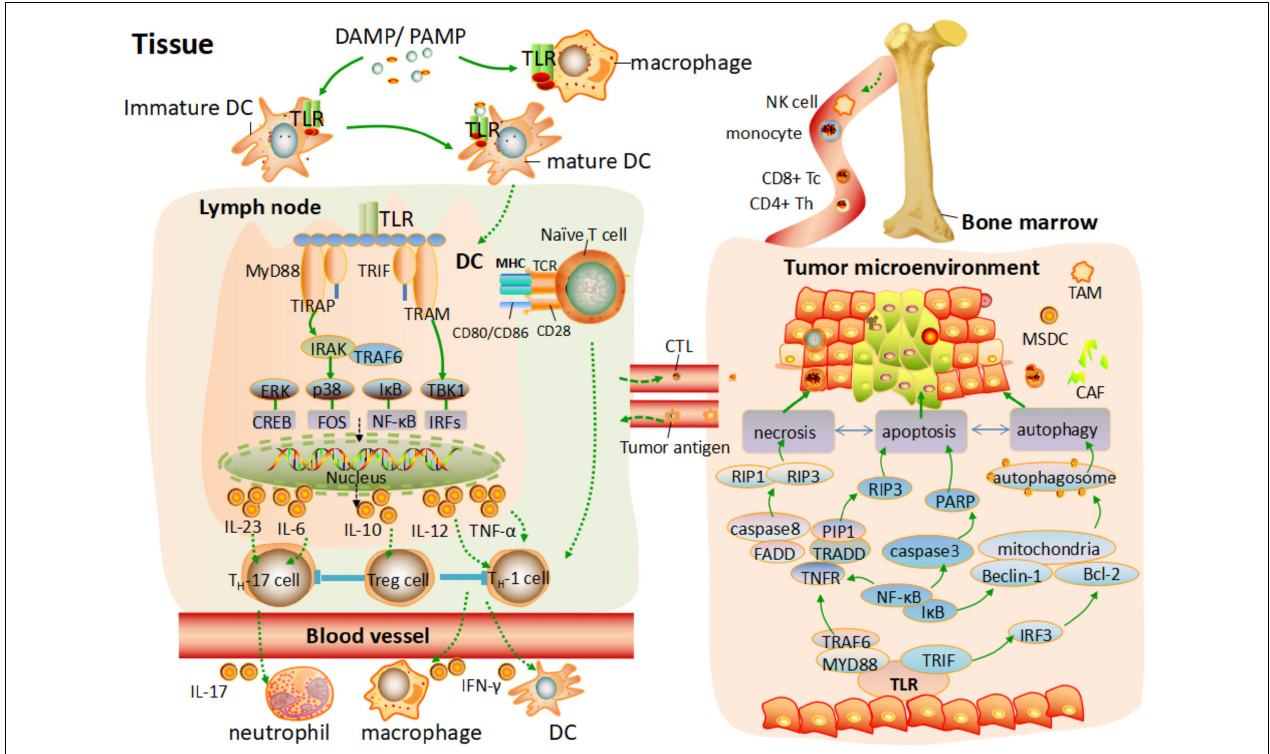
FIGURE 1 | TLRs mediated the T cells response and programmed cell death process toward tumor environment. After TLRs bind to PAMPs or DAMPs, the activation of pro-inflammatory response and different programmed cell death process are elicited. On one hand, various antigen-presenting cells (APC) are activated, and a programmed maturation is initiated to induce the migration of APC to lymph node. Different TLRs are activated by MYD88 and TRIF to elicit the downstream pathway, leading to the phosphorylation of NF- κ B or IRFs and consequent transcription of various genes coding pro-inflammatory cytokine. This cytokine production response to PAMPs/DAMPs and activates different subset of T cells. In addition, naive T cells in the lymph node activate. Differentiated T cells migrate through the blood to the tissue or tumor environment and are further activated by different factor. On the other hand, tumor gene-related programmed cell death is elicited by activation of TLRs signaling pathway. Apoptosis, autophagy, and necrosis are independent but have certain association with each other, which share the same signaling pathways or downstream effected adaptor to induce cancer cell